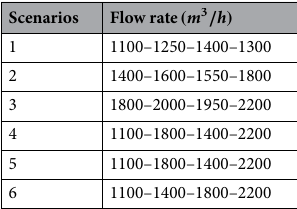
Table 4. Flow rate